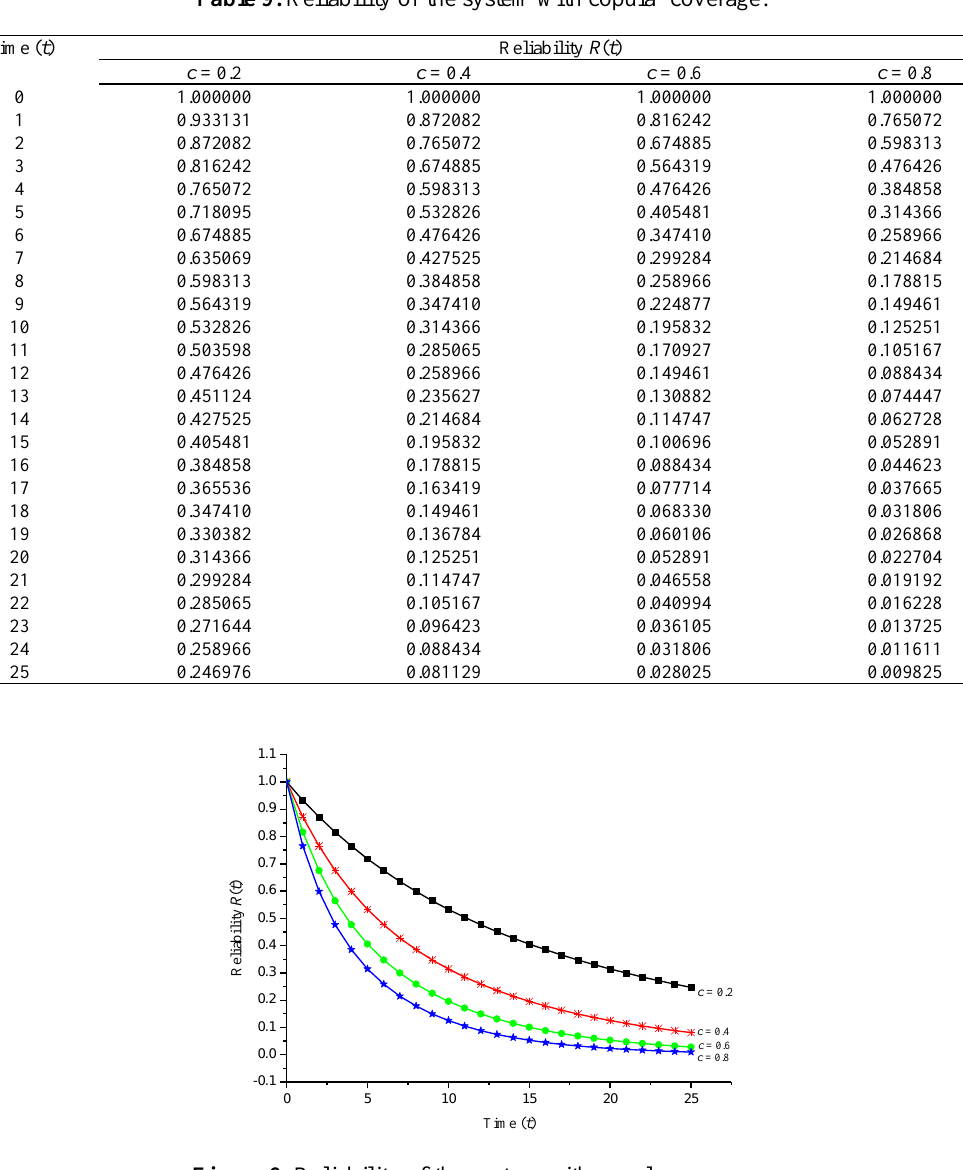
Figure 9. Reliability of the system with